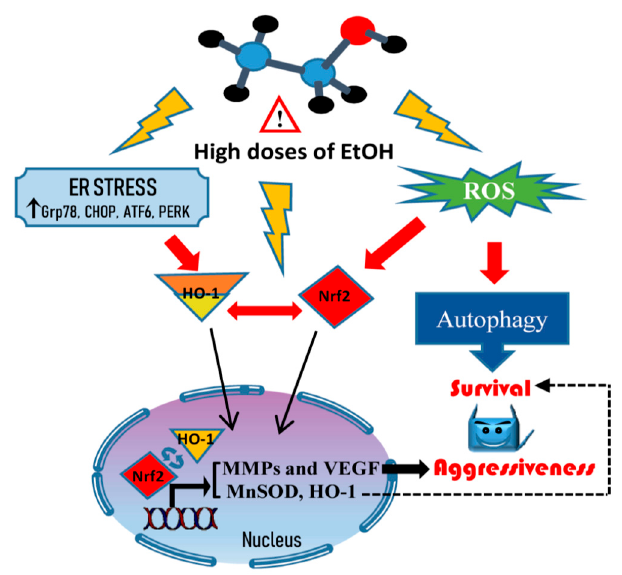
Figure 9. Scheme of the mechanism activated by high doses of ethanol. High doses of ethanol induce ROS generation and ER stress responsible for the induction of a prosurvival autophagic process and the aggressive tumor phenotype. Such events are sustained by the nuclear translocation of Nrf2 and HO-1, which activate antioxidant response systems and promote the upregulation of MMP2 and VEGF.